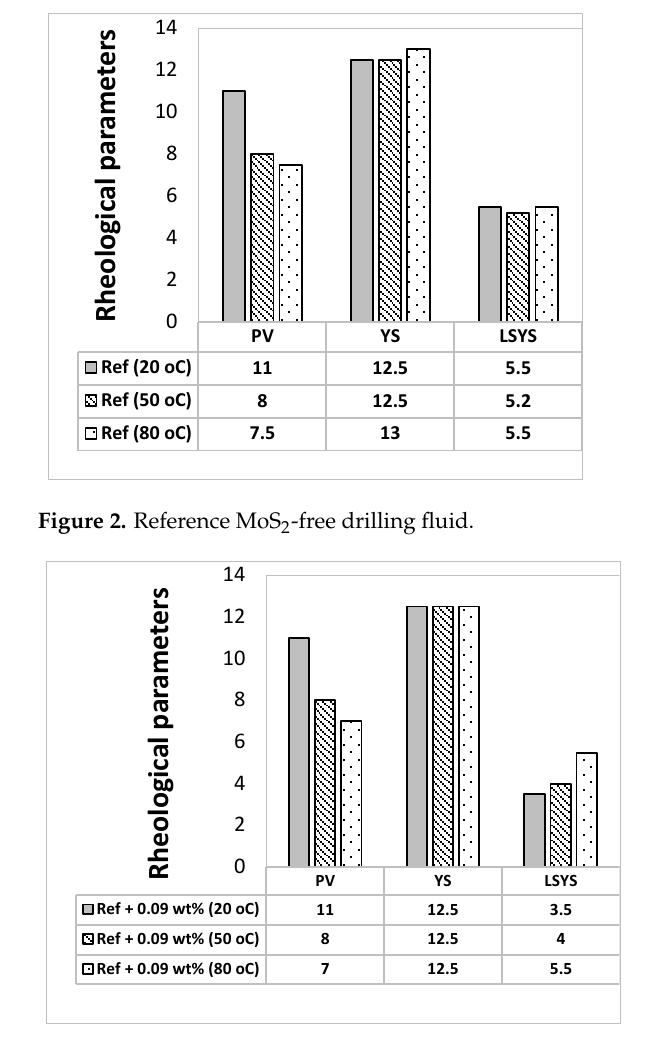
Figure 3. MoS 2 blended drilling fluid — 0.09 wt.%.